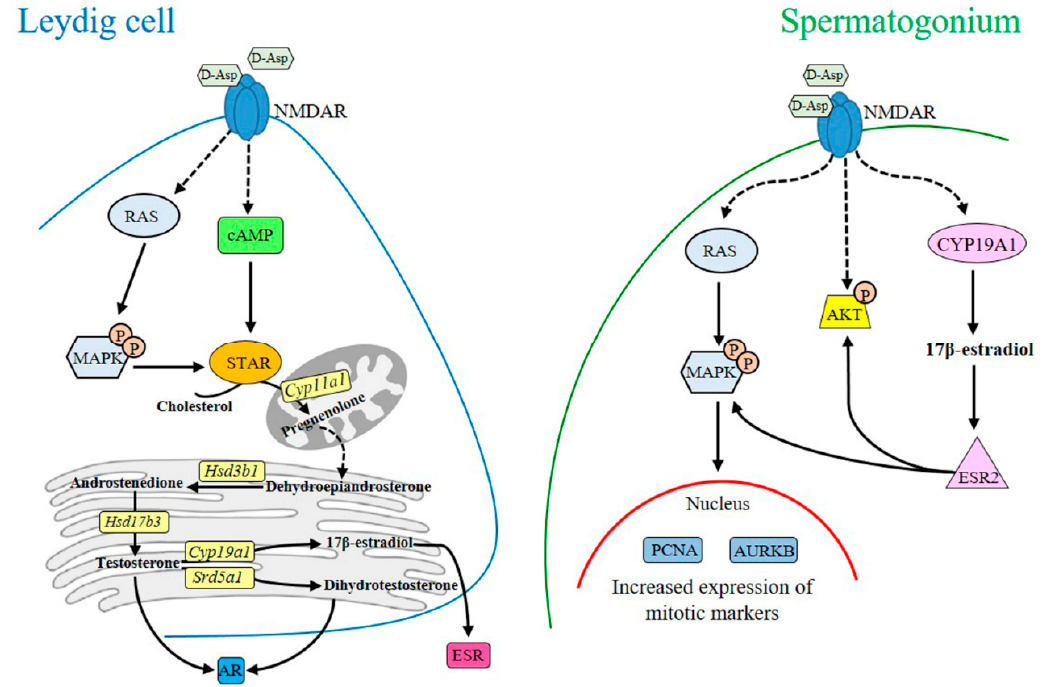
Figure 5. Schematic representation of molecular pathways activated by D -Asp in Leydig cell and spermatogonium. Through the activation of NMDAR, D -Asp up-regulates T production in Leydig cells by increasing STAR expression through cAMP and/or MAPK pathways. STAR regulates cholesterol transfer within the mitochondria. Further D -Asp affects gene expression of Cyp11a1 , Hsd3b1 , Hsd17b3 , Srd5a1 and Cyp19a1 enzymes as well as AR and ESR protein expression. In spermatogonial GC-1 cells, D -Asp may directly activate proliferation through MAPK and AKT pathways. Further stimulation of spermatogonial GC-1 cell proliferation could arise from estradiol/ESR2 interaction.